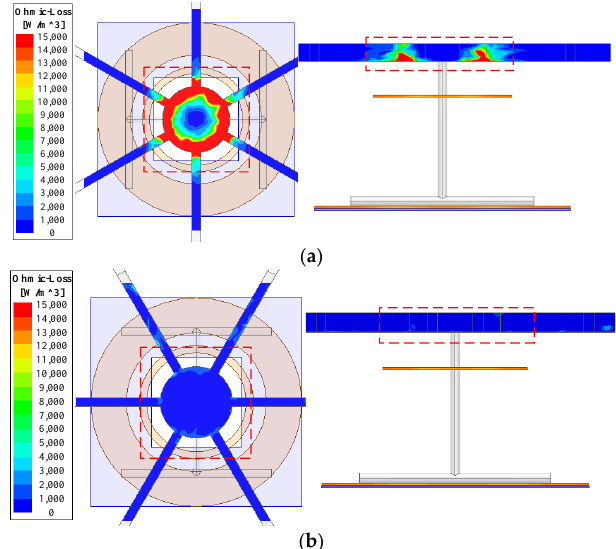
Figure 16. Eddy current loss distribution. ( a ) Without nanocrystalline and ( b ) with nanocrystalline.